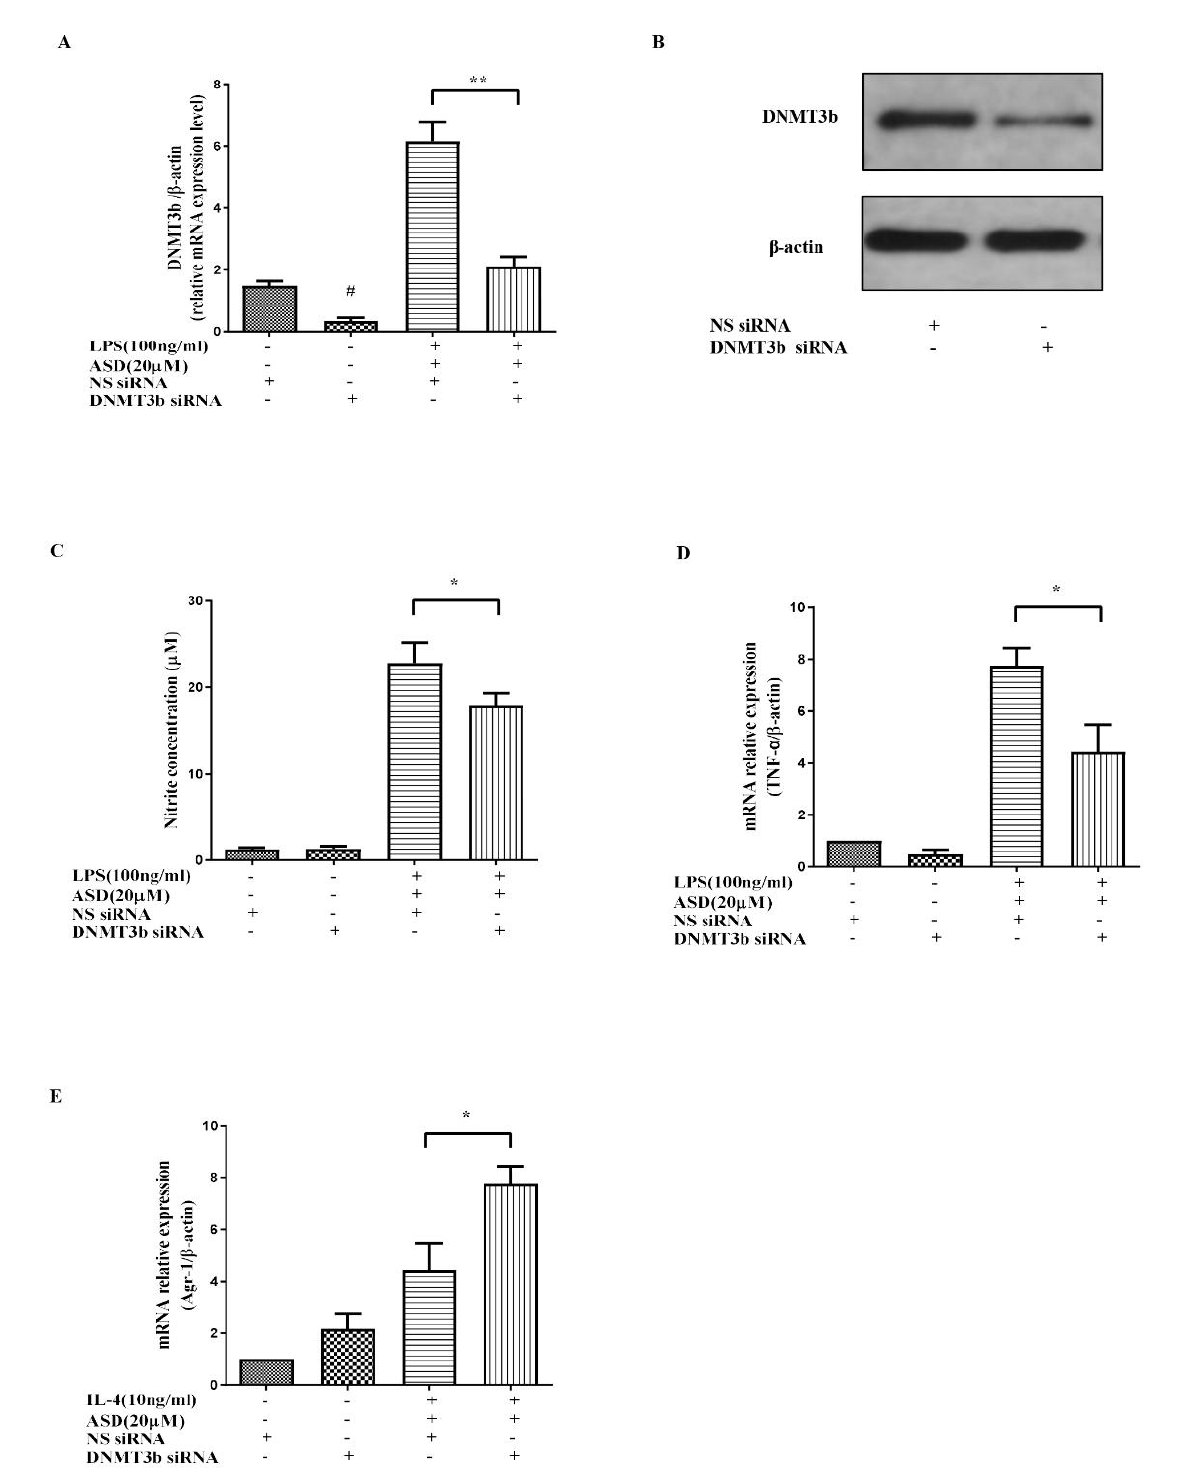
Figure 5. The effect of DNMT3b siRNA on the effect of ASD. The effect of DNMT3b siRNA on the expression of DNMT3b ( A , B ), NO ( C ), TNF- α ( D ), and Arg-1 ( E ). The data are shown as the average value ± SD. # p < 0.05 vs. NS siRNA-treated cells *, p < 0.05, vs. LPS and NS siRNA-treated cells, ** p < 0.01, vs. LPS and NS siRNA-treated cells ( A – E ). 3.6. Nrf2 siRNA Significantly Abolished the Effect of ASD on NO and HO-1 Nrf2-mediated antioxidant gene expression promotes anti-inflammatory effects [14].